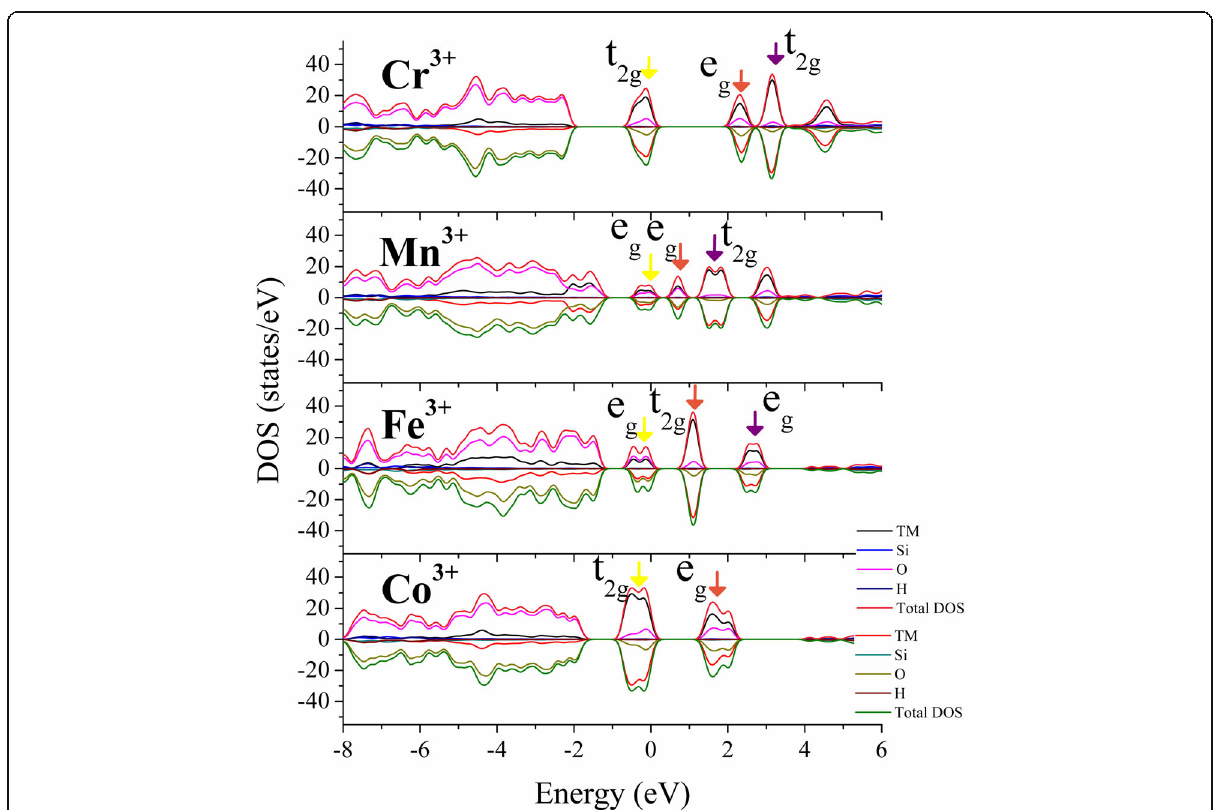
Fig. 3 Total density of states (DOS) and atom-projected density of states (PDOS) of the most stable states for TM doped kaolinite are given. The highest occupied 3d orbitals ( yellow ) and the first ( brown ) and second ( purple ) lowest unoccupied 3d orbitals around Fermi level are pointed by colored arrows